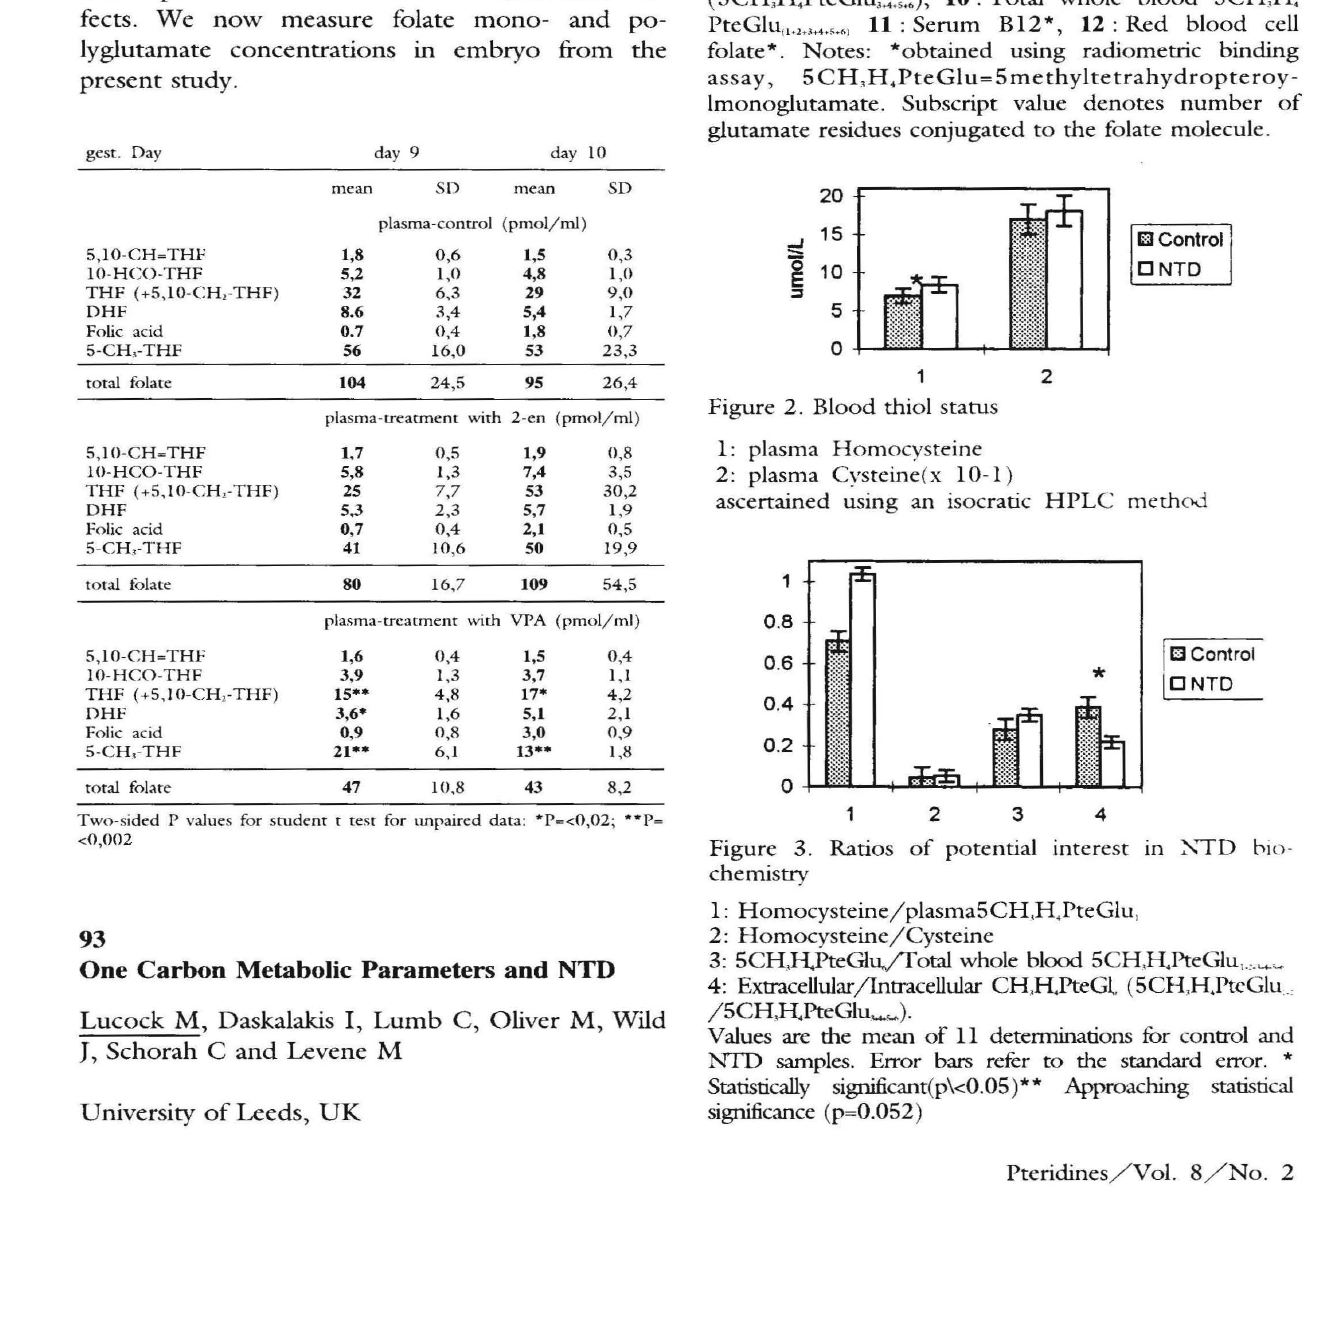
Figure 3. Ratios of potential interest In ~lD bio· chemistry 1: Homocysteine/plasma5CH.H.PteGlu, 2: Homocysteine/Cysteine 3: 5CH,H,PteGh.I./fotal whole blood 5CH.H.PteGlu 4: ExtracellularjIntracellular CHH.PteGl. (5CHH.PtcGlu /5CH.H.PteGlu ........ ). Values are the mean of 11 determinations for control and NID samples. Error bars refer to the standard error. * Statistically significant(p\<0.05)* * Approaching statistical significance (p=0.052) Pteridines/ Vol. 8/ No.